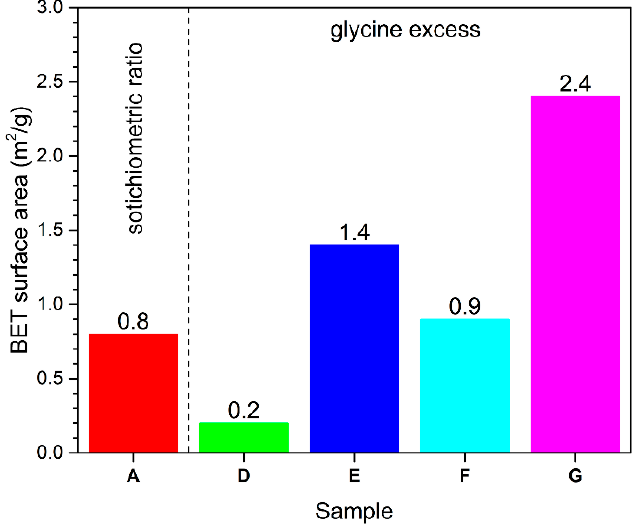
Figure 6. BET surface area of the samples (color codes: A—red, D—green, E—blue, F—turquoise, G—magenta).